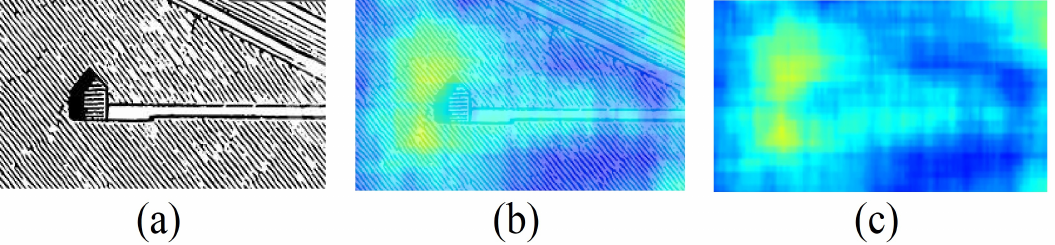
Figure 26. ( a ): Schematic representation of the queen’s chamber (box 2 details of Figure 24b). ( b ): Schematic representation of the queen’s chamber (box 2 details of Figure 24b) partially overlapped to tomographic result. ( c ): Figure 24b box 2 details tomographic result.